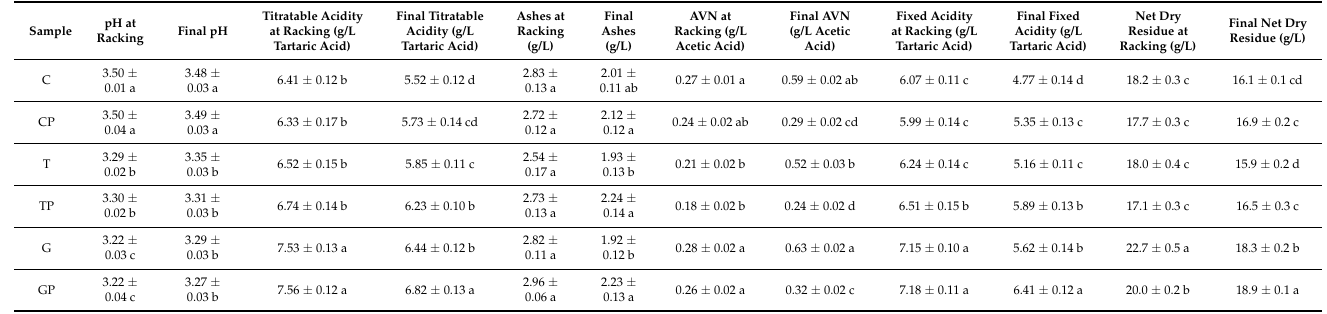
Table 7. Values of pH at racking, final pH, titratable acidity at racking, final titratable acidity, ashes at racking, final ashes, AVN at racking, fixed acidity at racking, final fixed acidity, net dry residue at rack- ing, and final net dry residue. C = Castellina, G = Gaiole, T = Tavarnelle, CP = Castellina plantarum, GP = Gaiole plantarum, TP = Tavarnelle